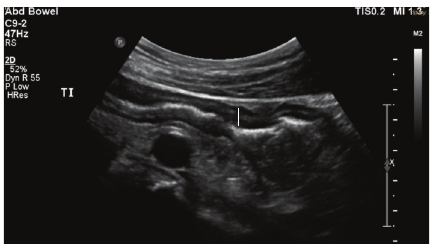
Figure 1: First suggestion of terminal ileal Crohn’s disease identified on sonography, with thickened distal ileum running over the hypoechoic iliac artery. The white line marks the thickened ileal wall with echogenic or white air in the lumen.